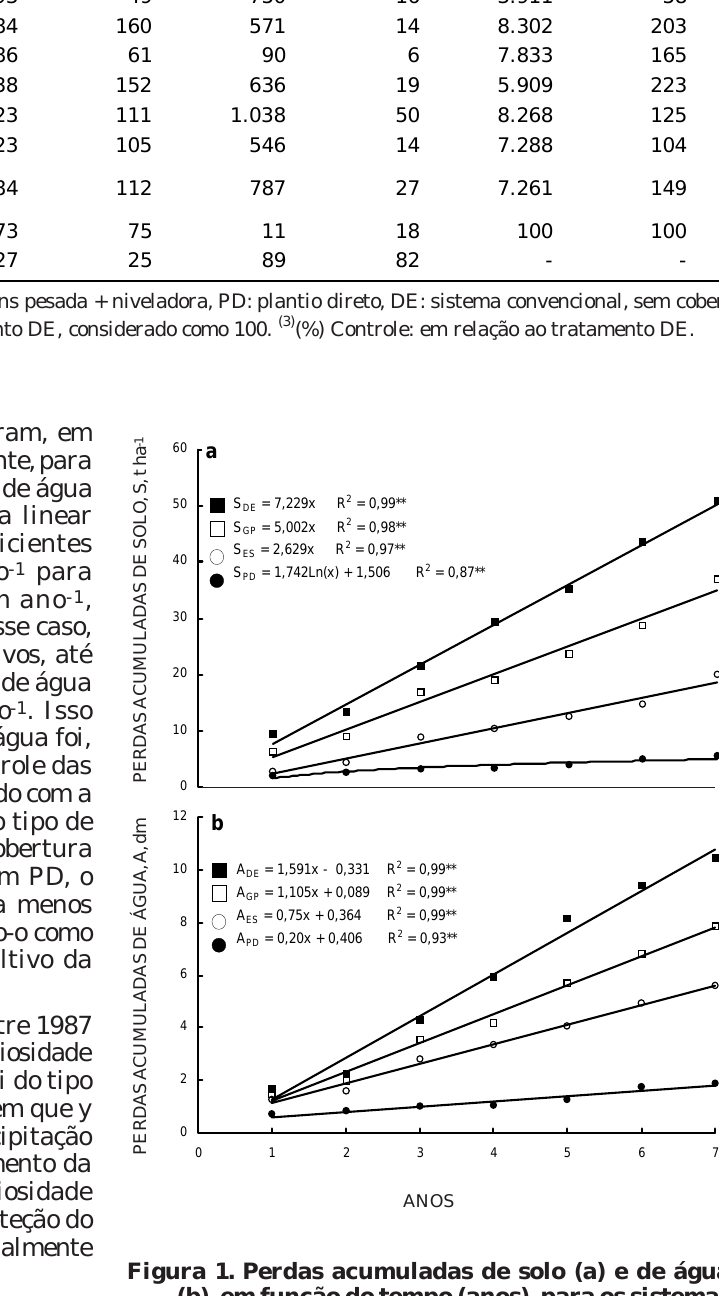
Figura 1. Perdas acumuladas de solo (a) e de água (b), em função do tempo (anos), para os sistemas de preparo: escarificação + gradagem niveladora (ES); gradagens pesada + niveladora (GP); plantio direto (PD) e aração + duas gradagens niveladoras, sem cobertura vegetal